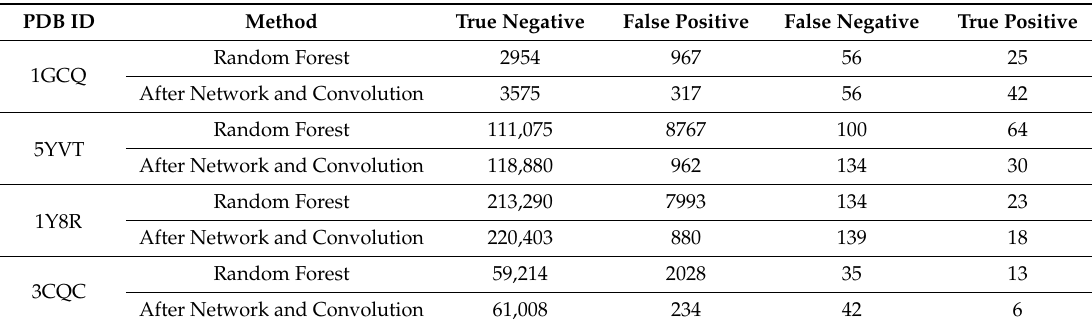
Table 3. Confusion matrix statistics for all test cases before and after network